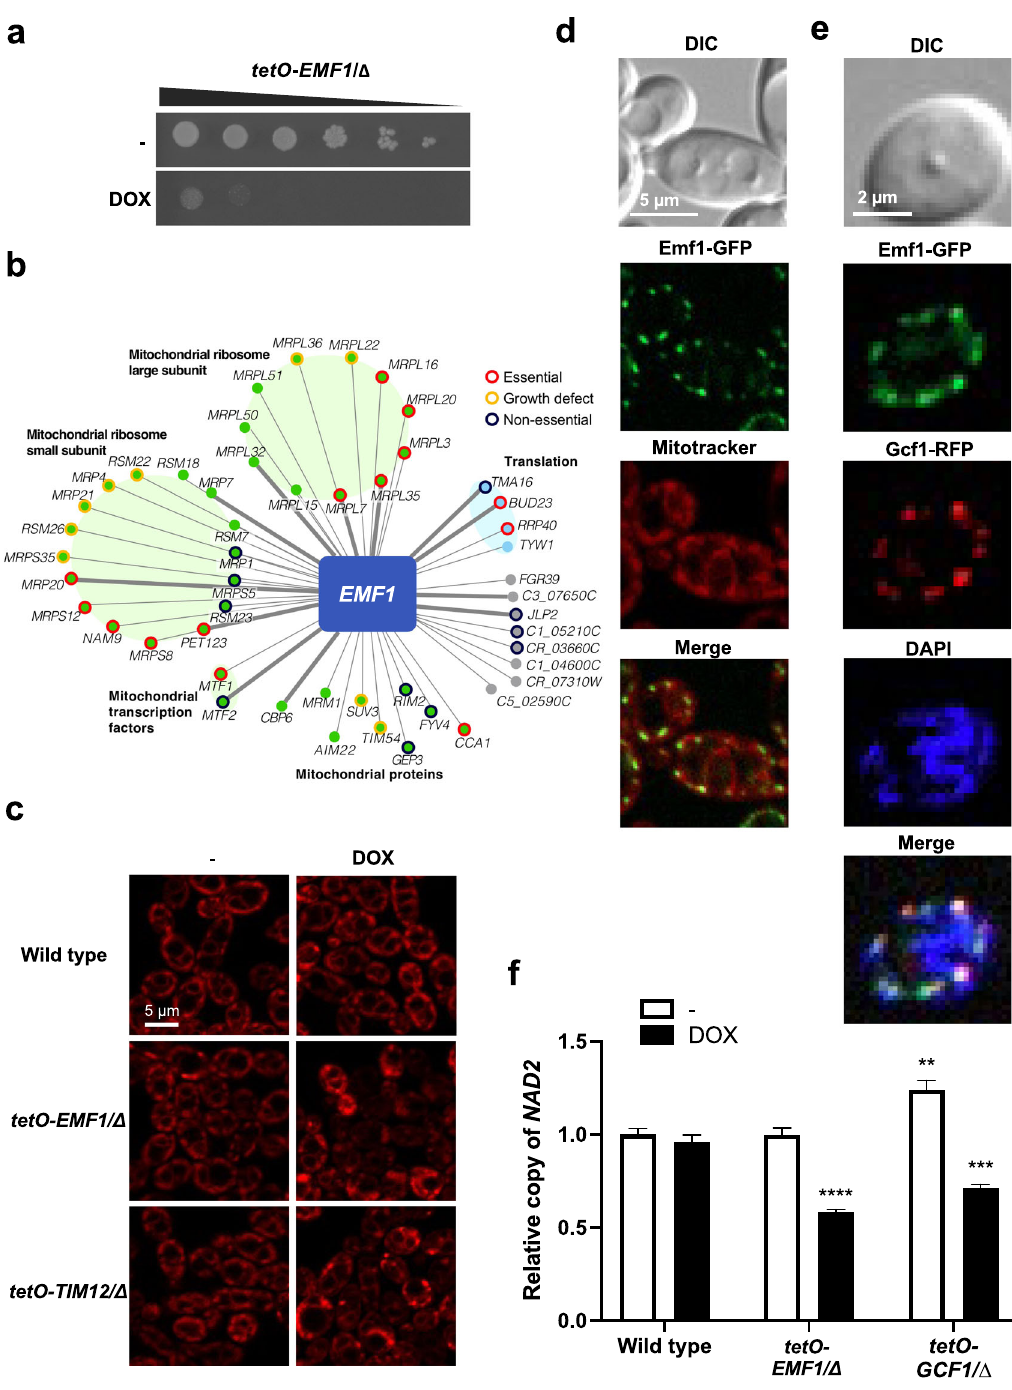
fl uorescence (Fig. 5d). Depletion of all putative translation initiation subunits, including the core eIF3c subunit NIP1 and our uncharacterized gene TIF33 , also caused a signi fi cant reduction in fl uorescence (Fig. 5d and Supplementary Fig. 4a), indicating translation was impeded. This was speci fi c to genes with roles in translation, as transcriptional repression of a control gene that was not involved in translation but was important for proliferation ( tetO-HSP90/hsp90 Δ ) still resulted in strong fl uorescence (Supplementary Fig. 4b). These results conclude Tif33 is an essential protein and a potential member of the eIF3 complex in C. albicans